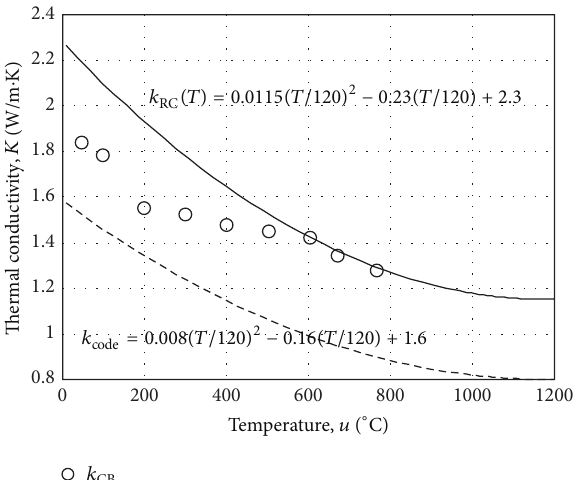
Figure 12: Regression analysis of (𝑇 𝑐 /𝑇 𝑔 ) 4 formulation versus time. (proposed RC (Korean code of CODE